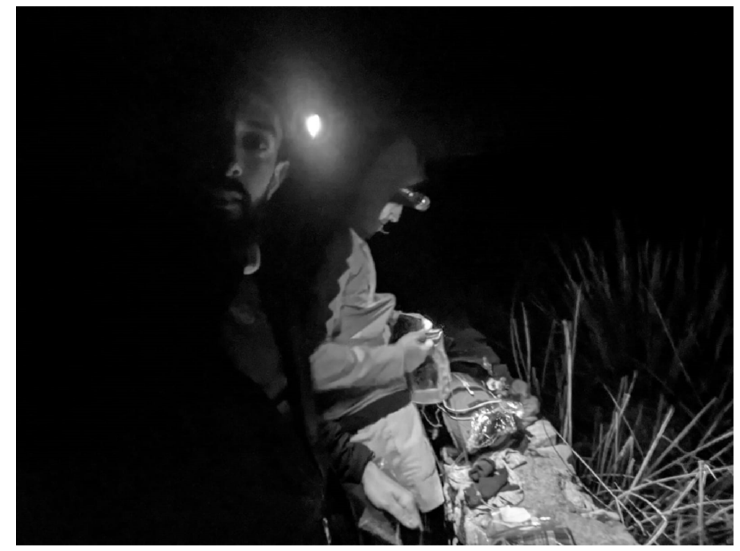
Figure 2. Data collection during the ultra-endurance event.